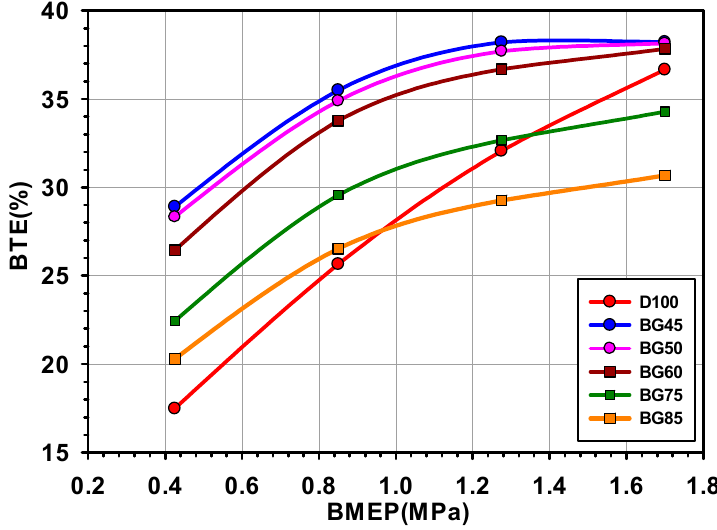
Figure 5. Variations of brake thermal efficiency (BTE) for D100 and biogas-diesel fuel.